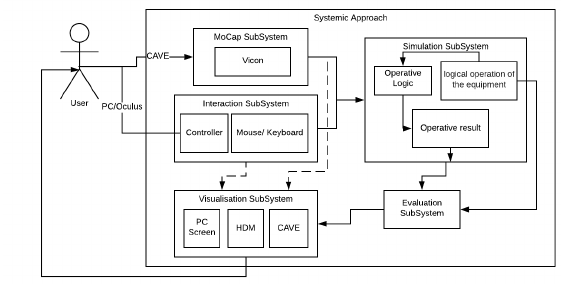
Figure 5. Game logic structure implemented in the game